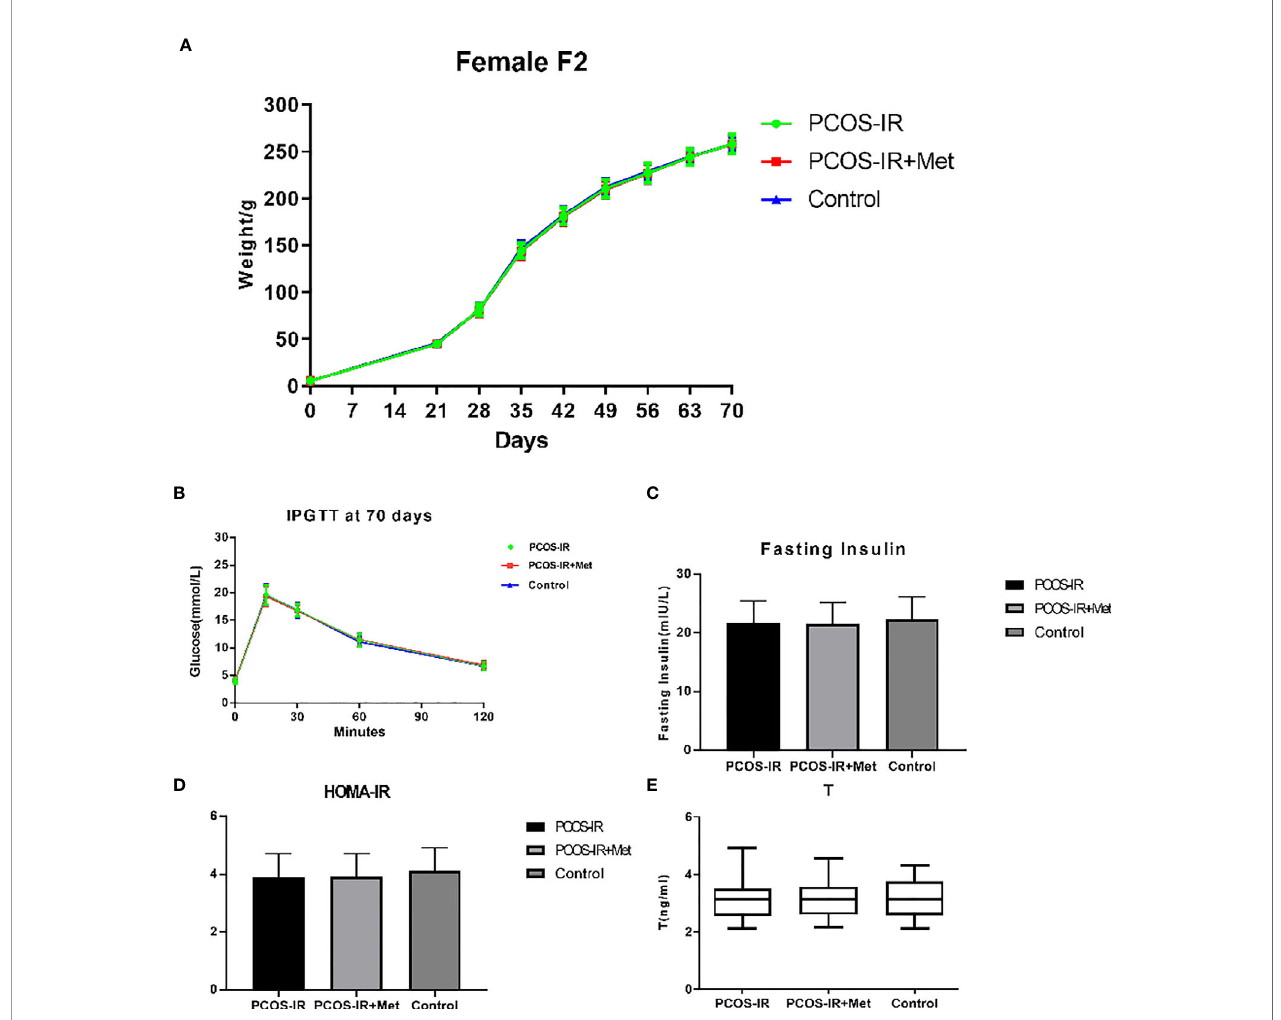
FIGURE 5 | The effects of metformin treatment on the endocrine and metabolic alterations in female F2 offspring. (A) Body weight changes in female F2 offspring (PCOS-IR group, n = 49; PCOS-IR+Met group, n = 53, Control group, n = 47); (B – E) Glucose, fasting insulin, HOMA-IR, and T changes in female F2 offspring (PCOS-IR group, n = 49; PCOS-IR+Met group, n = 53; Control group, n = 47). There were no signi fi cant changes during those groups,